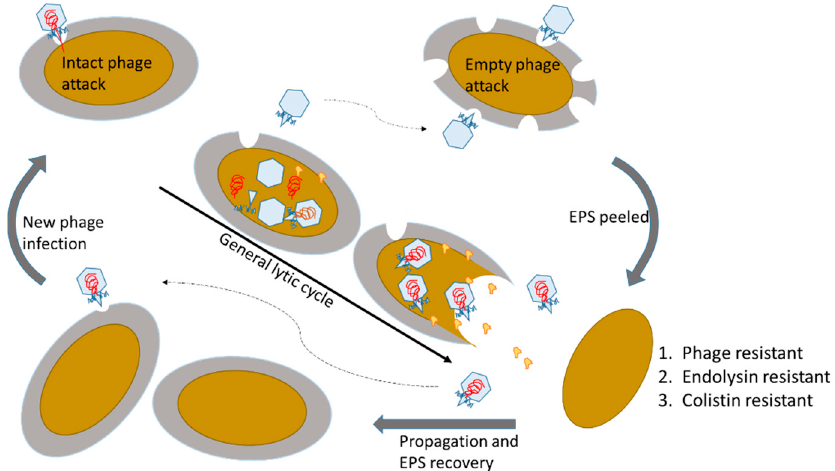
Figure 5. Scheme for the proposed resistance of exopolysaccharide (EPS) degraded bacteria. The initial step for EPS de- gradable phages is critically adhering the host EPS and degrading the host EPS to adsorb the host membrane, followed by injecting viral genome into the host cells. Loss of EPS reduces the phage binding efficiency. On the other hand, we also discovered that the EPS peeled bacterial cells strongly resist phage endolysin and colistin by reducing attachment of the positively charged amphipathic peptide.